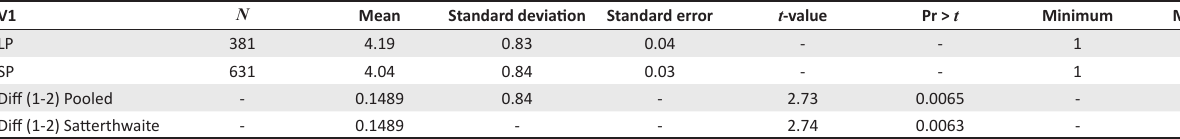
TABLE 10: Descriptive statistics of increase in entrepreneurial intention by programme duration V1